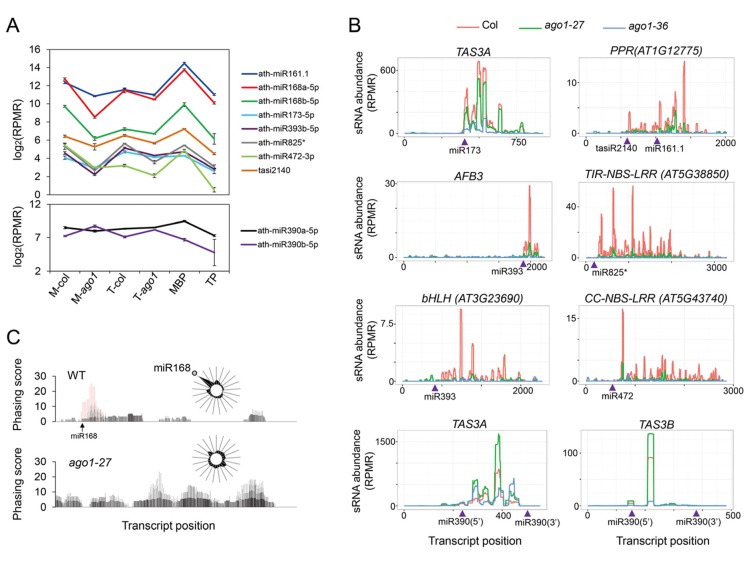
Biogenesis of phasiRNAs is defective in ago1-27.(A) top panel: abundance of known AGO1-dependent ta-siRNA/phasiRNA triggers in microsome (M), total (T), MBP and TP as determined by sRNA-seq; lower panel: abundance of miR390 in M, T, MBP and TP as determined by sRNA-seq. Wild type: col; ago1-27: ago1. Error bars indicate standard error of the mean (n = 3). (B) sRNAs from known ta-siRNA/phasiRNA loci, except for TAS3 loci, were reduced in ago1-27 (green) as compared with wild type (red), and nearly diminished in ago1-36 (blue). The loci IDs are shown above each plot. The miRNA triggers for these ta-siRNAs/phasiRNAs are shown below each plot with the miRNA-binding sites indicated by triangles. (C) The phasing of sRNAs over the AGO1 transcript in wild type and ago1-27. miR168 triggers the production of phasiRNAs (with positions marked by red lines) in wild type, and the phasing caused by this miRNA was nearly lost in ago1-27. The radial graphs show that the miR168 cleavage site fell in the most prominent phasing register of 21-nt sRNAs in wild type but not in ago1-27.